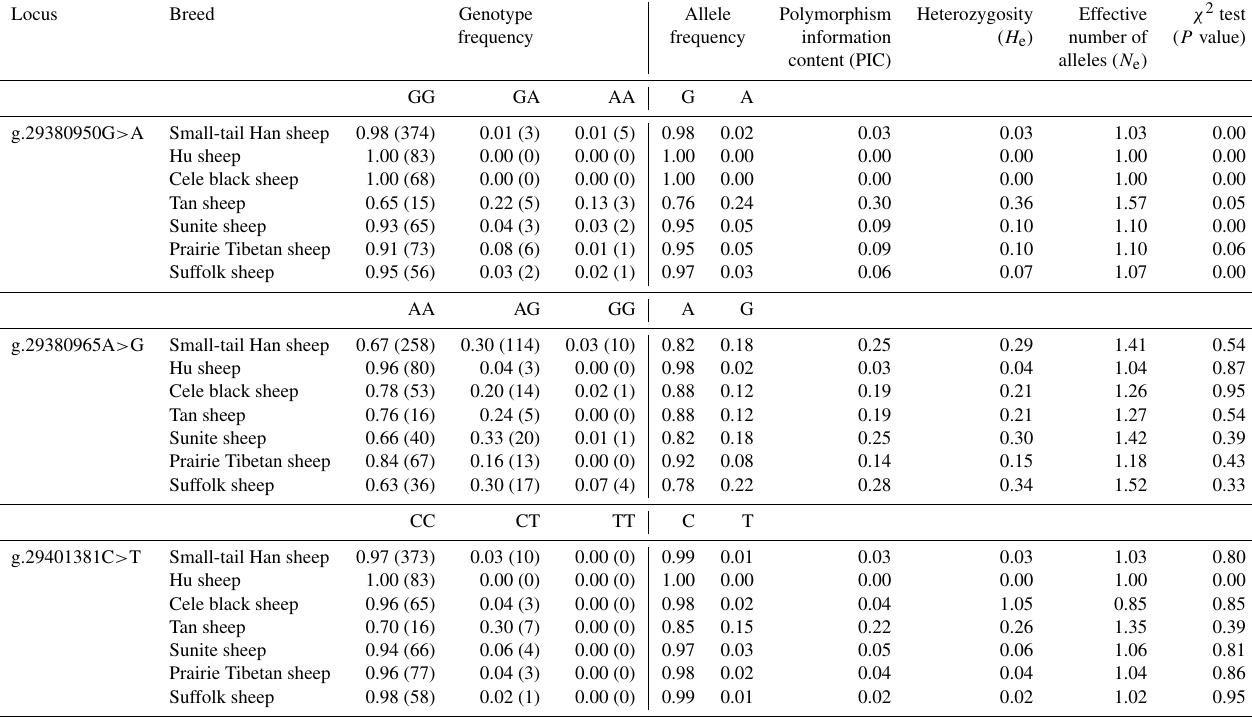
Table 4. Population genetic analysis of different SNPs of the BMPR1B gene in seven sheep breeds. Locus Breed Genotype